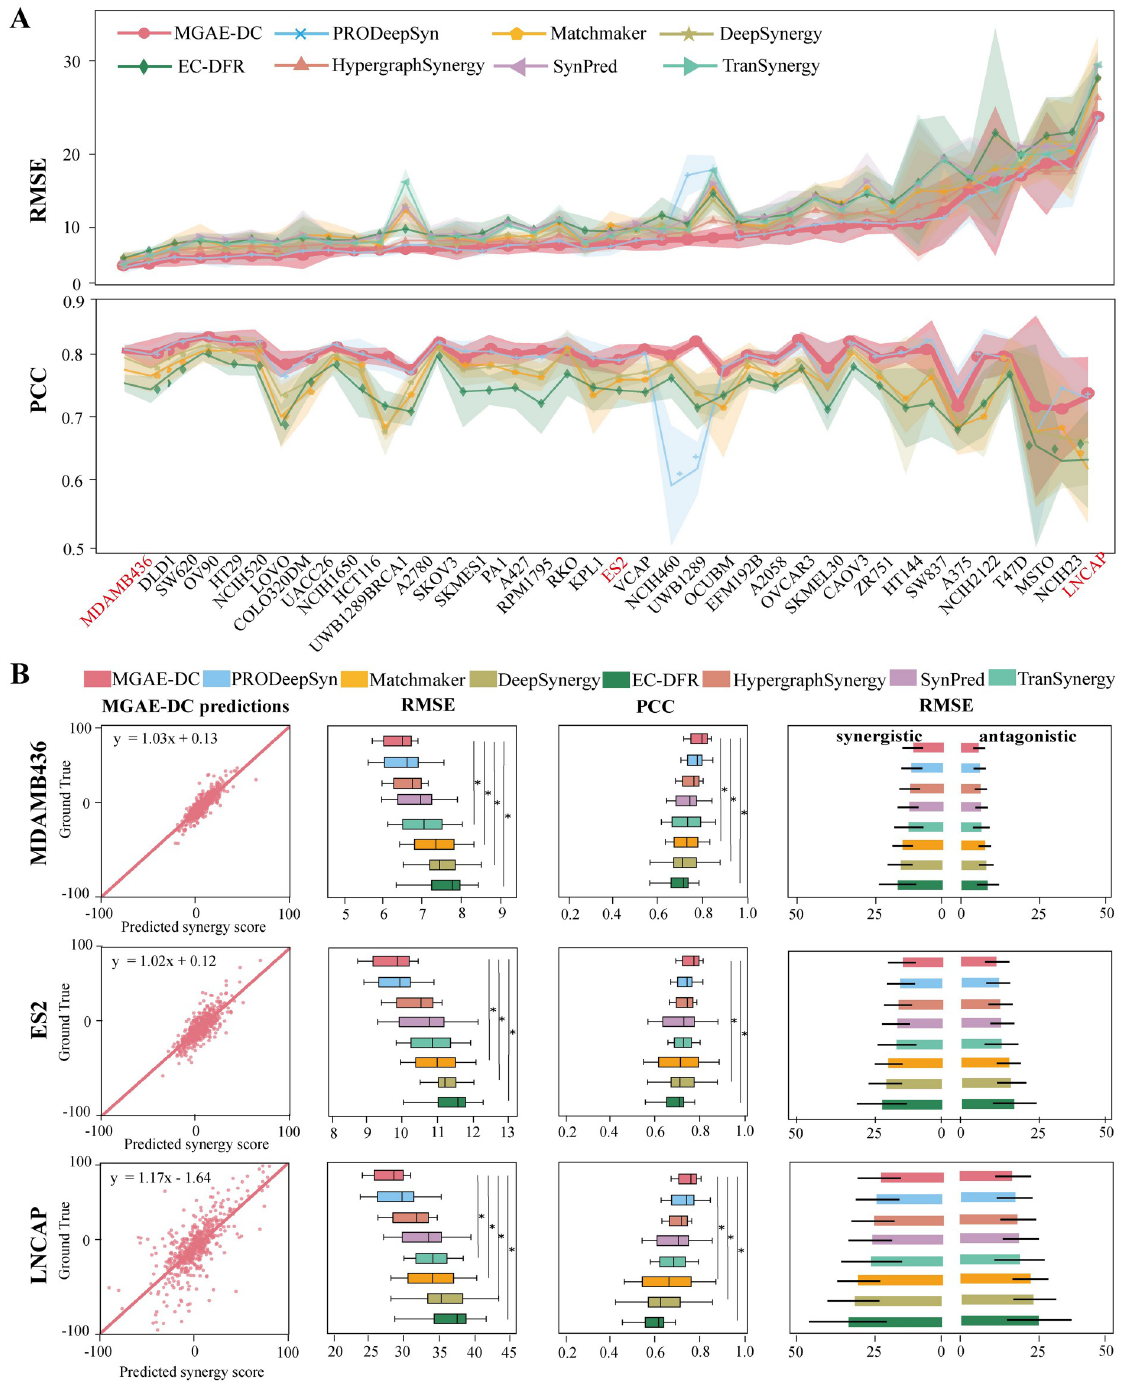
Fig 2. The performances of different methods in each cell line. (A) The RMSE and PCC of different methods in each cell line. The mean values of different folds are shown as solid lines. Error bars in terms of one standard deviation are shown as shaded areas. (B) The performances of different methods in the three representational cell lines. For each cell line, the scatter plot of MGAE-DC predicted synergy scores and the ground truth, the boxplots of RMSE and PCC of different methods, the RMSE of different methods in the synergistic and antagonistic drug combinations, respectively. The P-values are calculated by Wilcoxon signed-rank test. � represents P-value � 0.05.